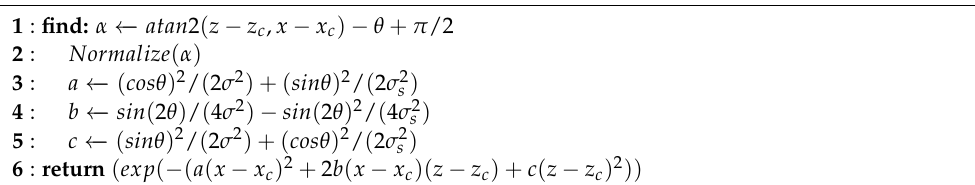
Algorithm 1: Asymmetric Gaussian-based-heat map